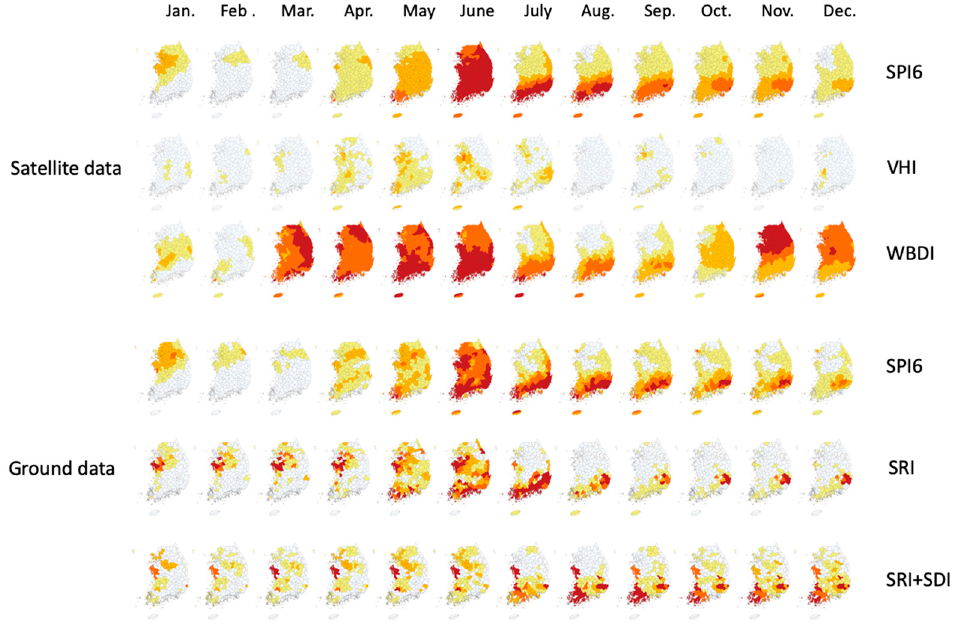
Figure 7. Comparison of drought index calculation results based on satellite data and ground data in